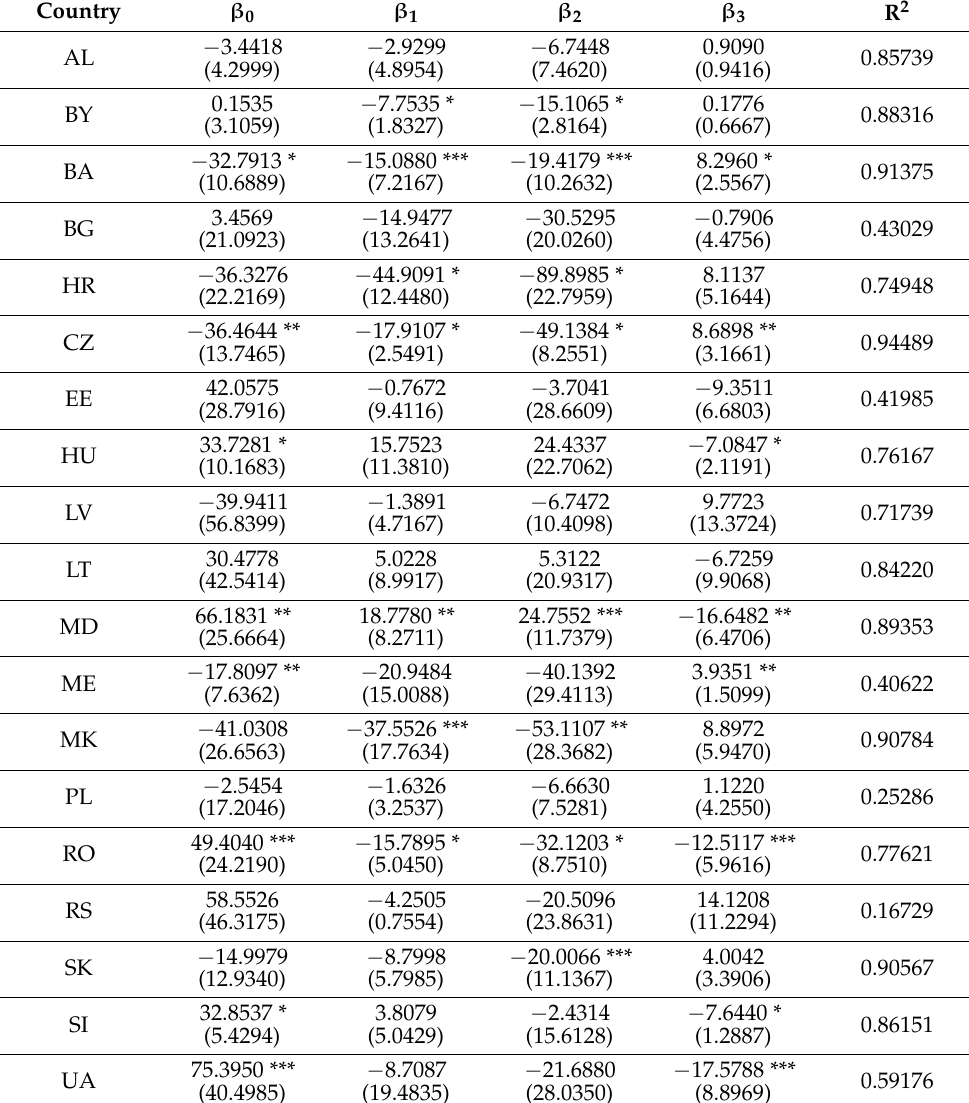
Table 8. Estimation of model parameters for independent variables HDI index and